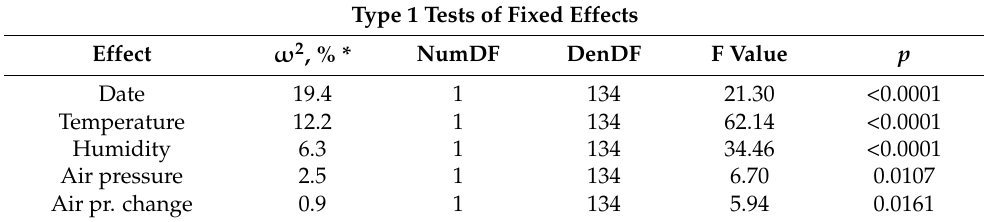
Table 6. Shannon diversity index of nightly trap catches as a function of weather variables, a glmm model with trap location as a random variable. Type I analysis; definitive model obtained by backward elimination is presented. Switching the order of humidity and temperature in the model did not lead to qualitatively different